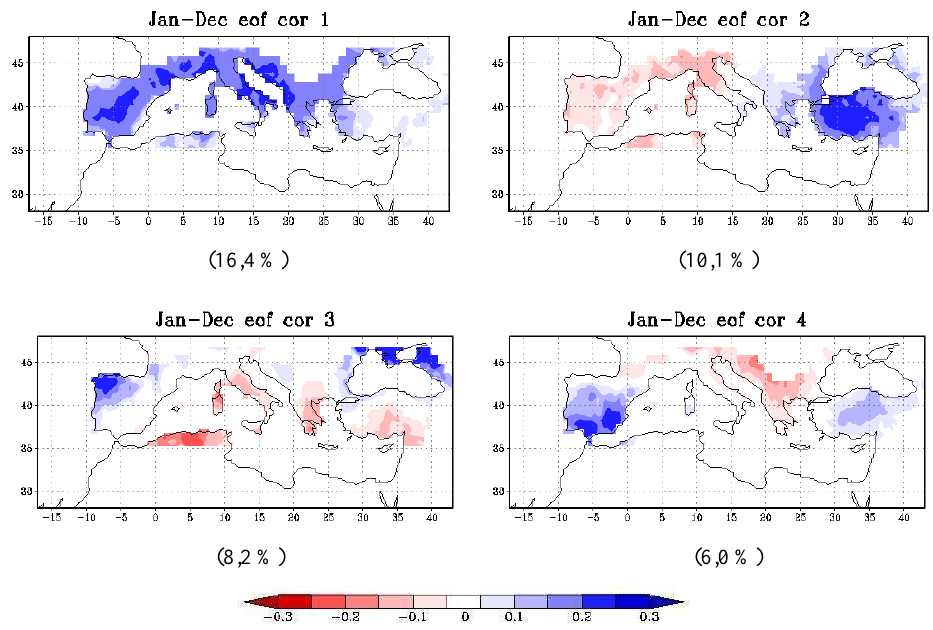
Fig. 3. The first four EOFs (based on the correlation matrix) for the Mediterranean scPDSI index during the 20th century and their contri- bution to the total variance. Each EOF pattern was multiplied by its corresponding eigenvalue square root, in order to obtain the correlation coefficients between each PC and the original scPDSI field.